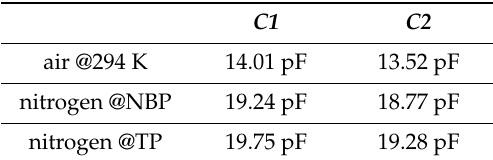
Table 2. Calibration of the capacitors C1 and C2 .